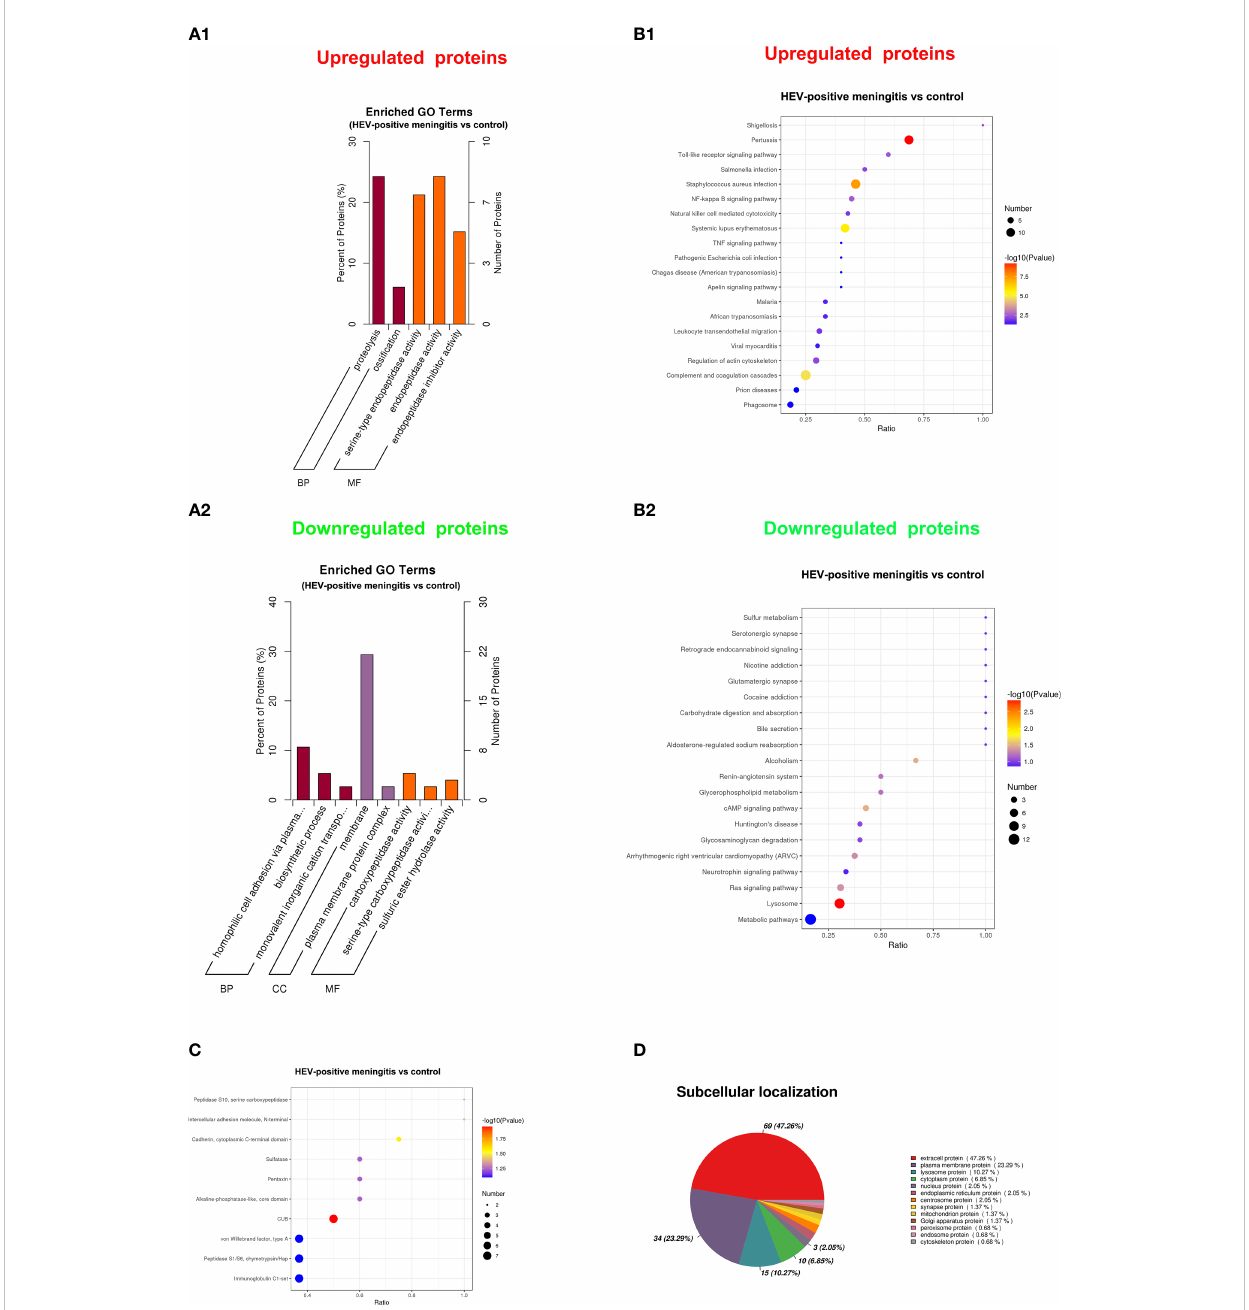
FIGURE 4 Functional analysis of DEPs between patients with encephalitis and normal controls. (A) GO enrichment bar chart of DEPs presents the number and percentage of DEPs enriched in a biological process (BP), cellular component (CC), and molecular function (MF) between the patients with encephalitis and normal controls. (A1) upregulated expressed proteins; (A2) downregulated expressed proteins. (B) The bubble chart shows the KEGG pathway enrichment analysis of DEPs between two groups. (B1) upregulated expressed proteins; (B2) downregulated expressed proteins. (C) InterPro (IPR) annotation of DEPs between patients with encephalitis and normal controls and the top 10 domain annotations represented in the chart. (D) Subcellular localization of DEPs between patients with encephalitis and normal